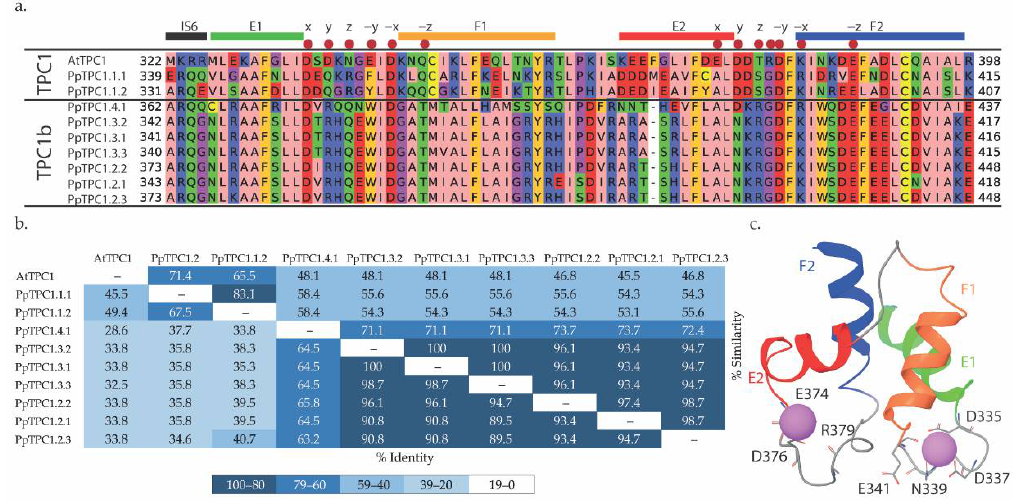
Figure 3. EF-hand sequences of TPC1-type channels from A. thaliana and P. patens . ( a ) Sequence alignment, separating between TPC1 and TPC1b. The TPC1 group consisted of AtTPC1 and the PpTPC1-sequences from cluster 1. The TPC1b group consisted of the PpTPC1-sequences of clusters 2–4. For each sequence, the residue numbers of the beginning and end of the EF-hand domains are shown. Zappo staining was used to distinguish the characteristics of the residues: negatively charged (red), positively charged (blue), polar (green), aromatic (mustard), hydrophobic (pink), cysteine (yellow), and proline and glycine (purple). Colored bars on top of the alignment indicate the alpha-helix structure of the EF-hands of AtTPC1. Red dots indicate residues reported for calcium-binding in the AtTPC1 EF-hands. ( b ) Identity/similarity matrix of the EF-hand sequences of TPC1 channels from A. thaliana and P. patens . Numbers above the diagonal represent the percentage of similarity and those below the diagonal represent the percentage of identity. ( c ) Fragment of the AtTPC1 channel (PDBID:6E1N) corresponding to the EF-hands. The alpha helices E and F are color-coded as on the top of panel ( a ). Residues reported for Ca 2+ binding that form hydrogen bonds in this crystal are highlighted.